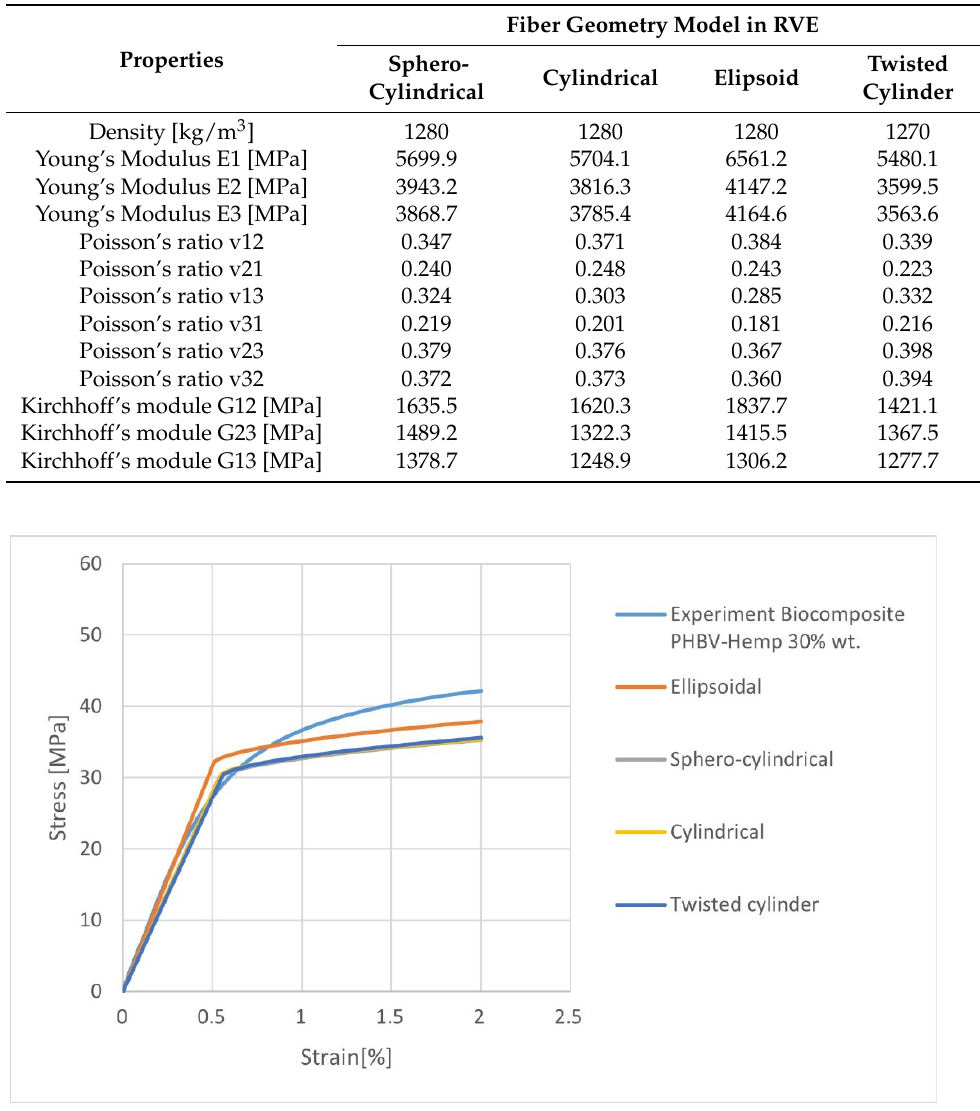
Figure 10. Stress-strain characteristics for K30 biocomposites with variable types of fiber geometry. Table 9. The predicted properties of the biocomposite PHBV -hemp fiber for variable types fiber geometry in RVE .